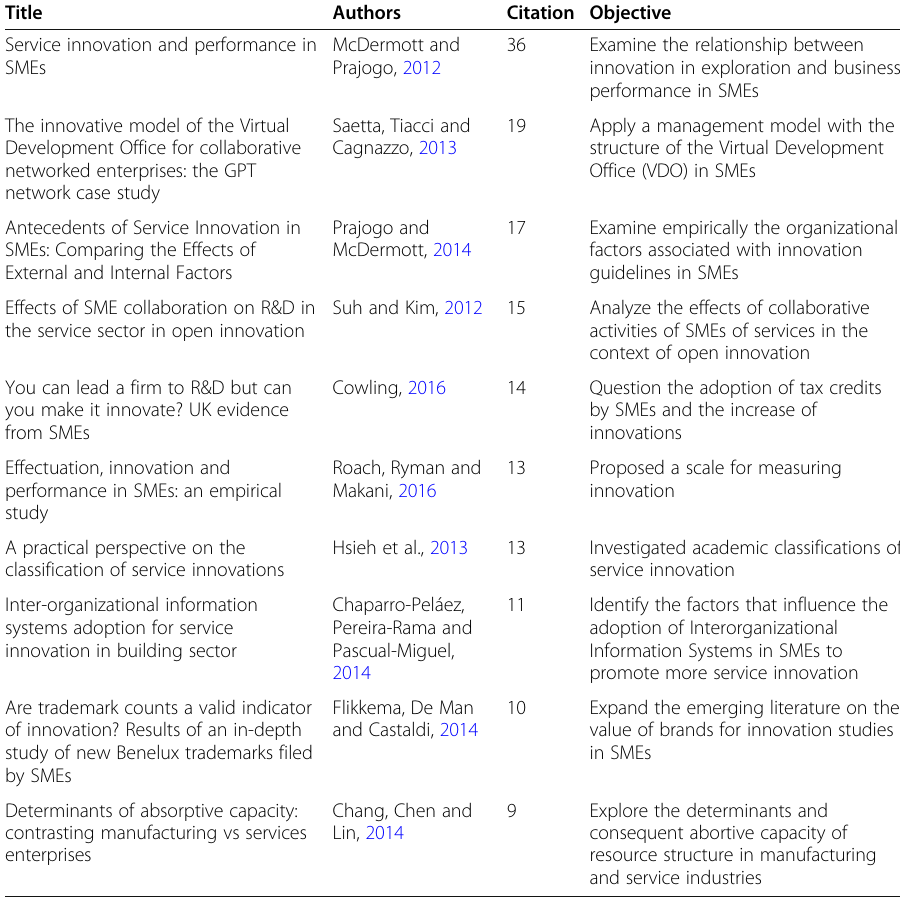
Table 3 Top 10 of the most cited papers of the research